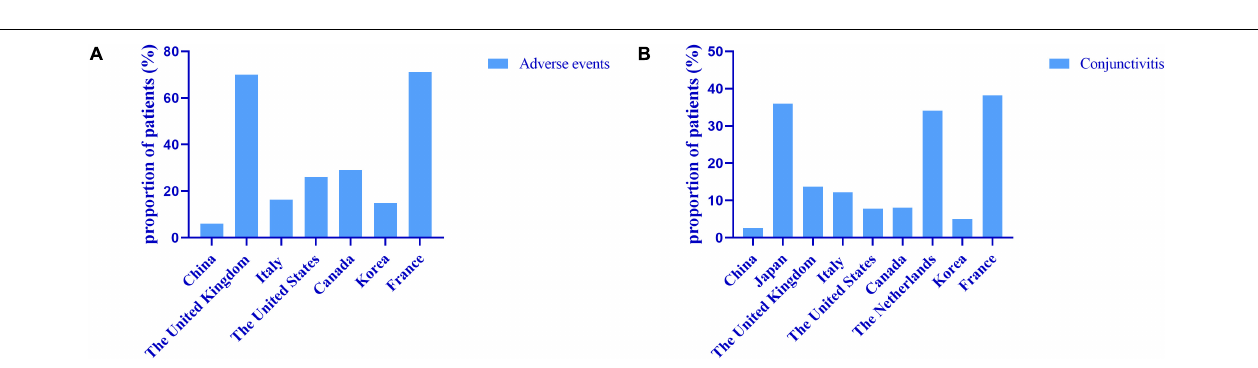
FIGURE 4 | Representative photos of AD patients whose conditions did not improve after treatment with dupilumab. Case 3, case 4 represent two different patients. From left to right, respectively, for the baseline (A,D) , 2 weeks (B,E) , and 4 weeks (C,F) after giving dupilumab.